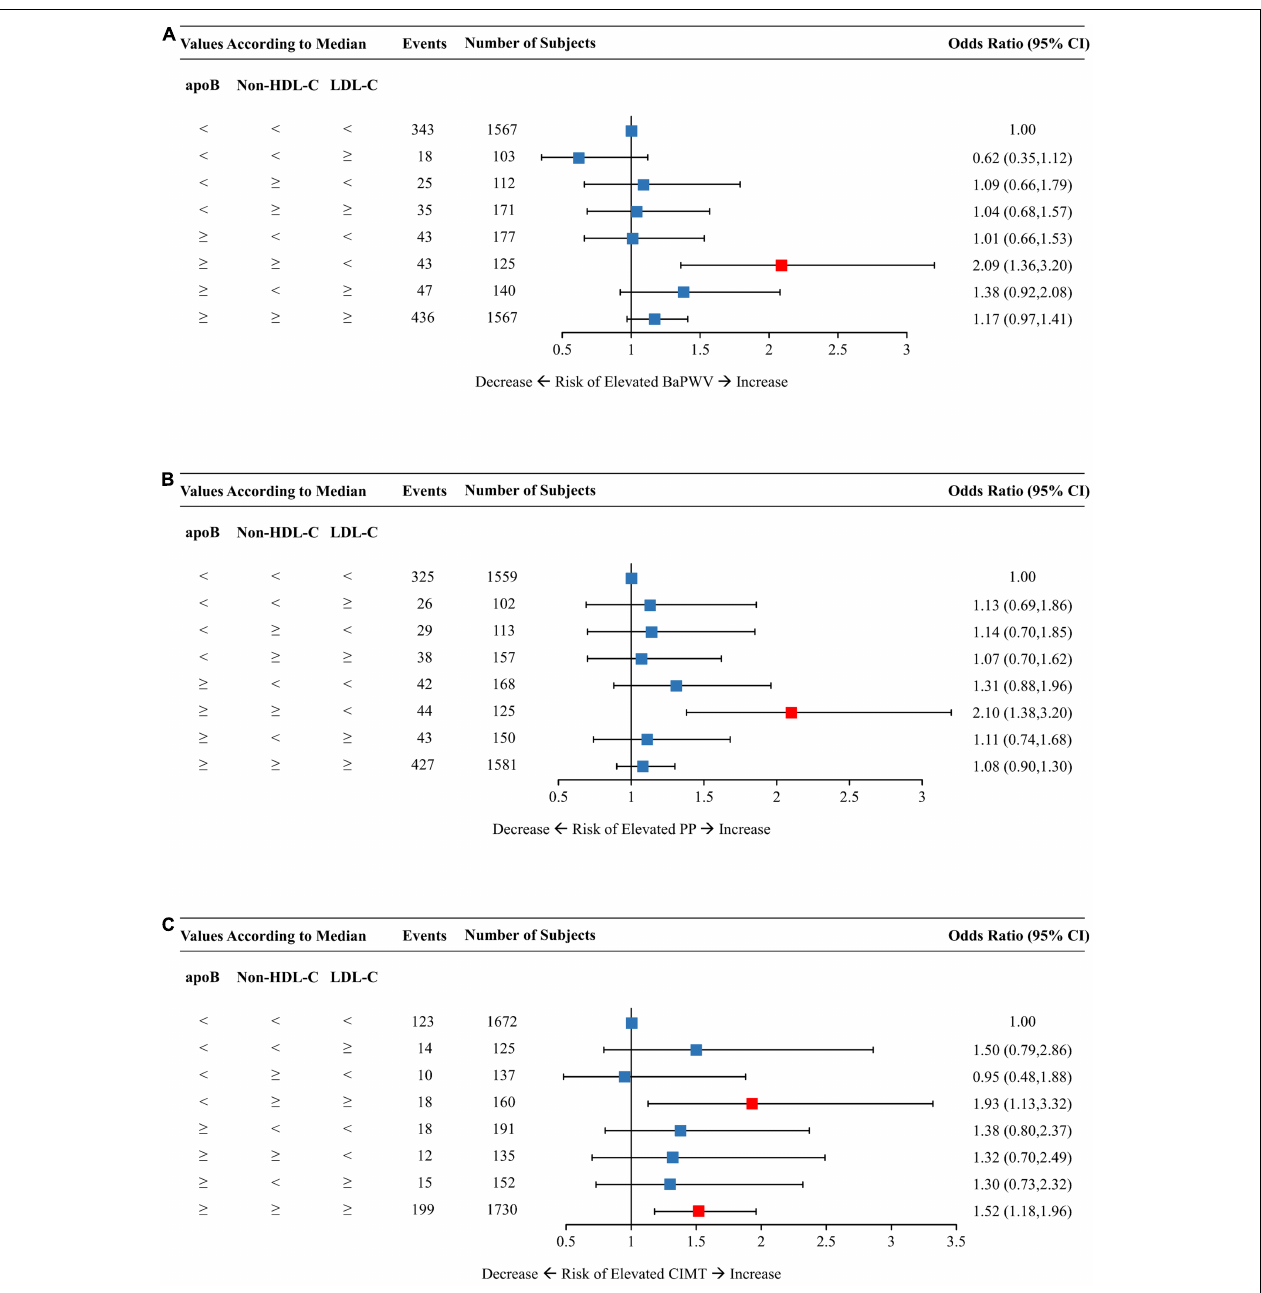
FIGURE 4 | Multivariable-adjusted odds ratios of elevated baPWV (A) , PP (B) , and CIMT (C) by discordant vs. concordant categories of apoB, non-HDL-C, and LDL-C. The concordance/discordance categories are defined based on the medians of apoB, LDL-C, and non-HDL-C concentration levels in each analysis. The concordant group with apoB, LDL-C, and non-HDL-C all below the median is used as reference. Model was adjusted for baseline age, sex, BMI, smoking status, drinking status, physical activity, glucose-lowering therapy, and lipid-lowering therapy. ApoB, apolipoprotein B; Non-HDL-C, non-high-density lipoprotein cholesterol; LDL-C, low-density lipoprotein cholesterol; BaPWV, brachial-ankle pulse wave velocity; PP, pulse pressure; CIMT, carotid intima-media thickness; CI, confidence interval; BMI, body mass